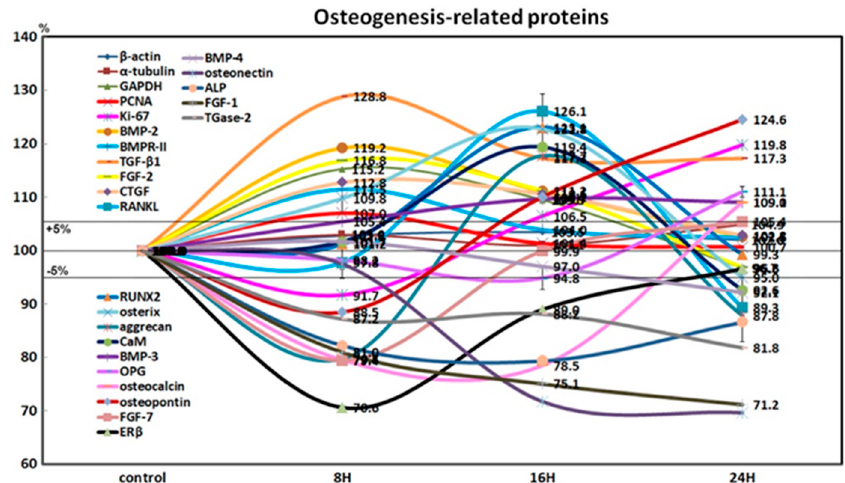
Figure 3. Expression of osteogenesis-related proteins ( n = 21) in 4HR-treated Saos-2 cells, as determined by high-performance liquid chromatography. The line graph shows protein expression patterns on the same scale (%) versus culture time (8, 16, or 24 h).